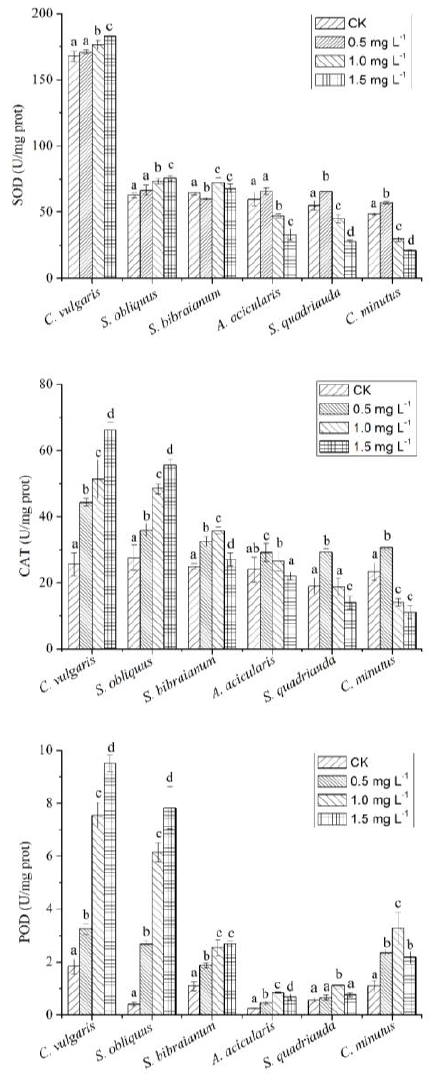
Figure 3. Effects of NP on activities of superoxide dismutase (SOD), catalase (CAT), and peroxidase (POD) in microalgae. Algae were treated with NP at 0.5, 1.0, and 1.5 mg L − 1 culture for 96 h, and then the activities were assayed. Mean and standard deviation of three replicates are shown. Means with different letters at each NP concentration for each algal species indicate that they were significantly different at p < 0.05 according to a one-way ANOVA test. NS: not significant.